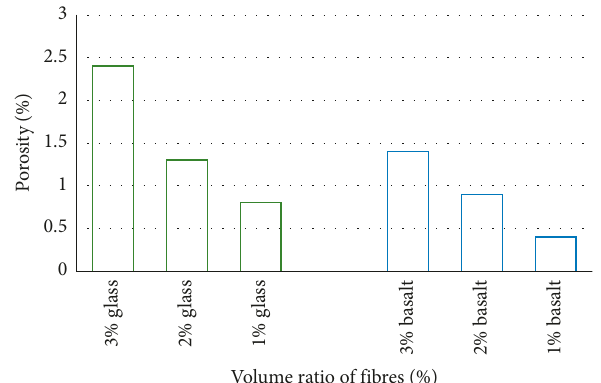
Figure 3: Porosity of materials with the specified fibre volume